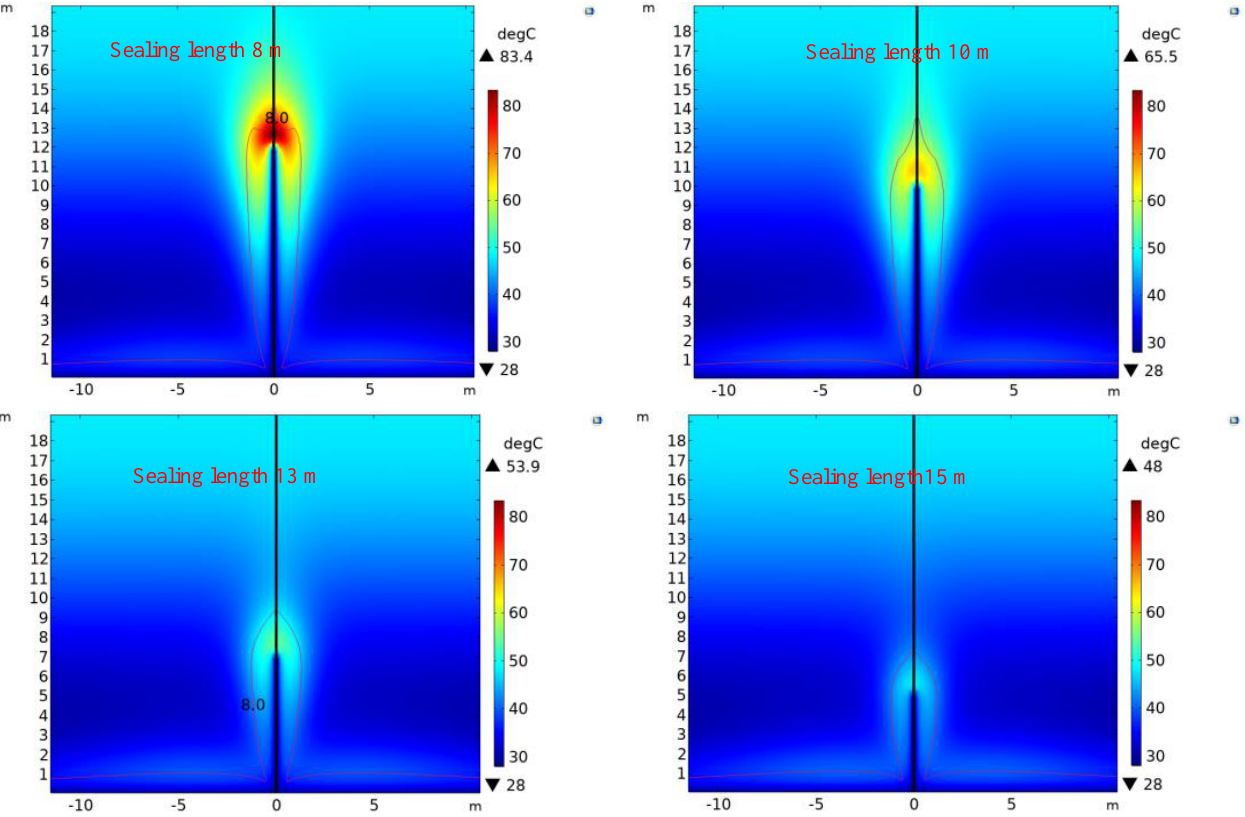
Figure 10. The temperature cloud map of the coal body around the borehole.